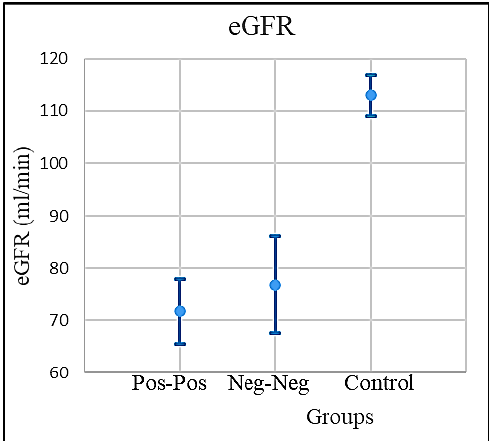
Figure 6. The eGFR mean levels and the confidence intervals for COVID-positive, COVID-free patients, and the control groups.